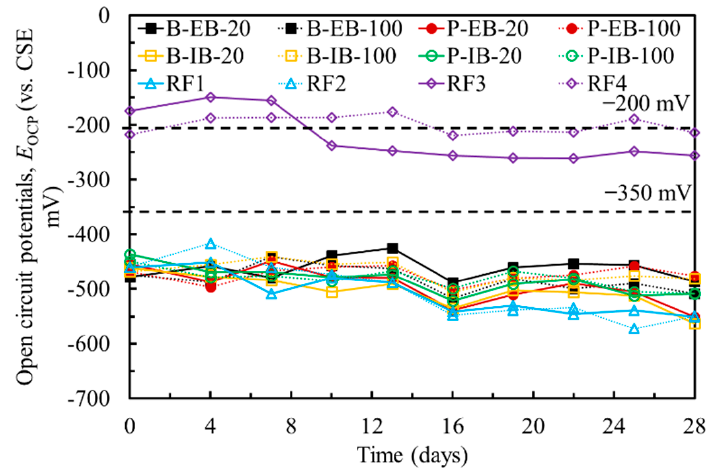
Figure 4. Open circuit potentials of steel in all the specimens during the 28-day curing period.